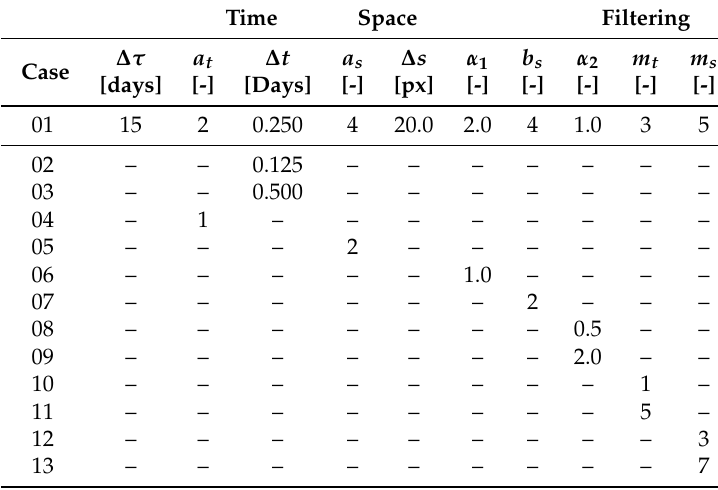
Table 2. Values considered for the combination and the filtering steps, where – indicates that it is the same value as in case 01